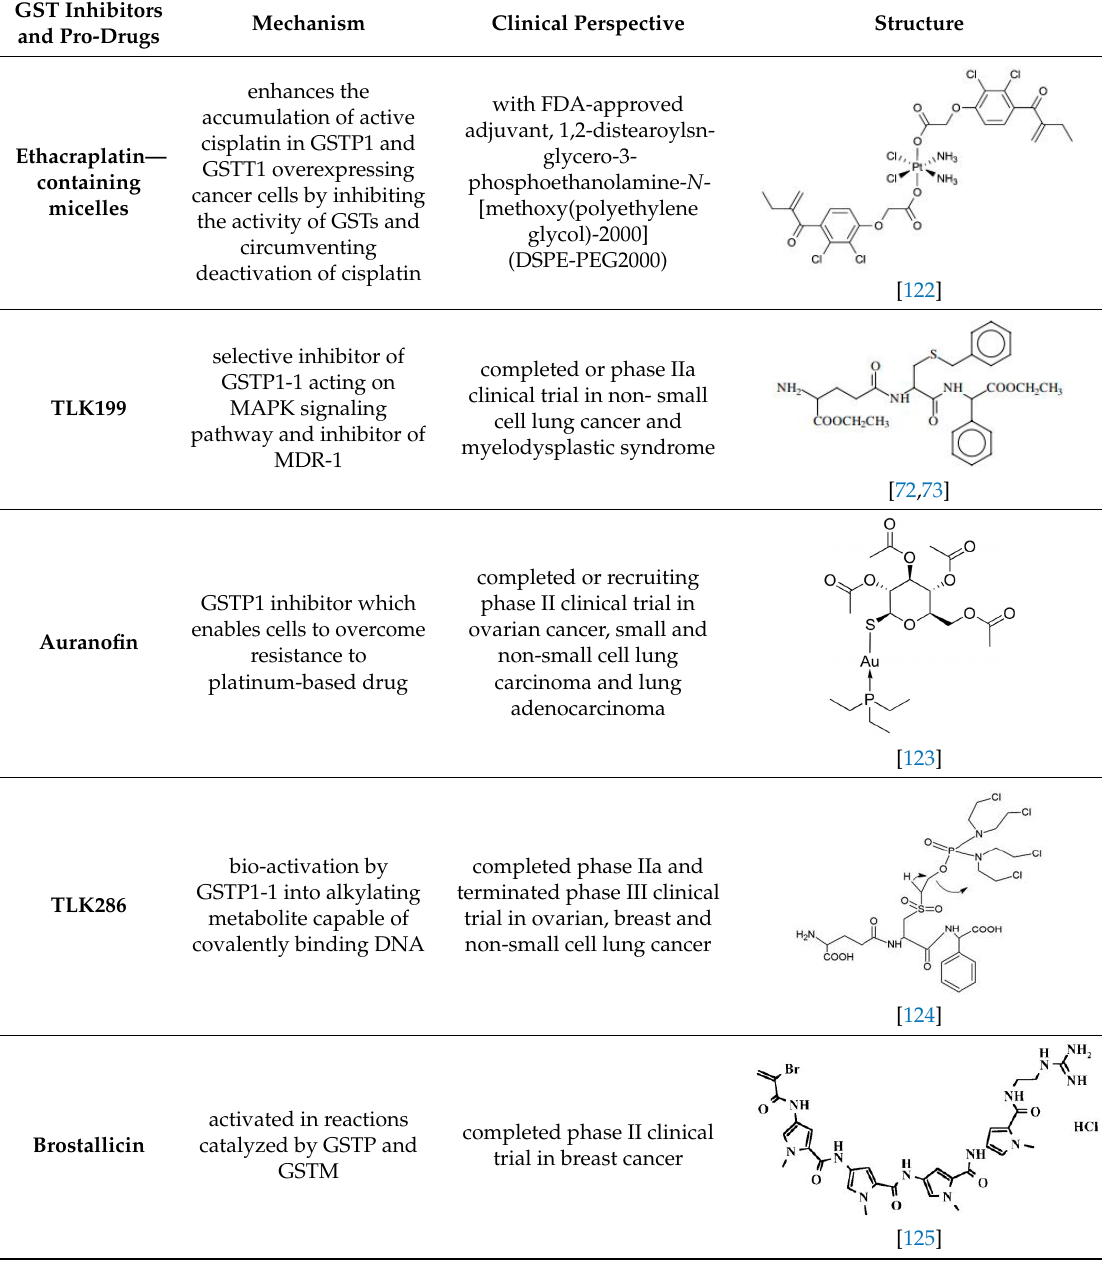
Table 2. GST inhibitors and pro-drugs with clinical perspective.